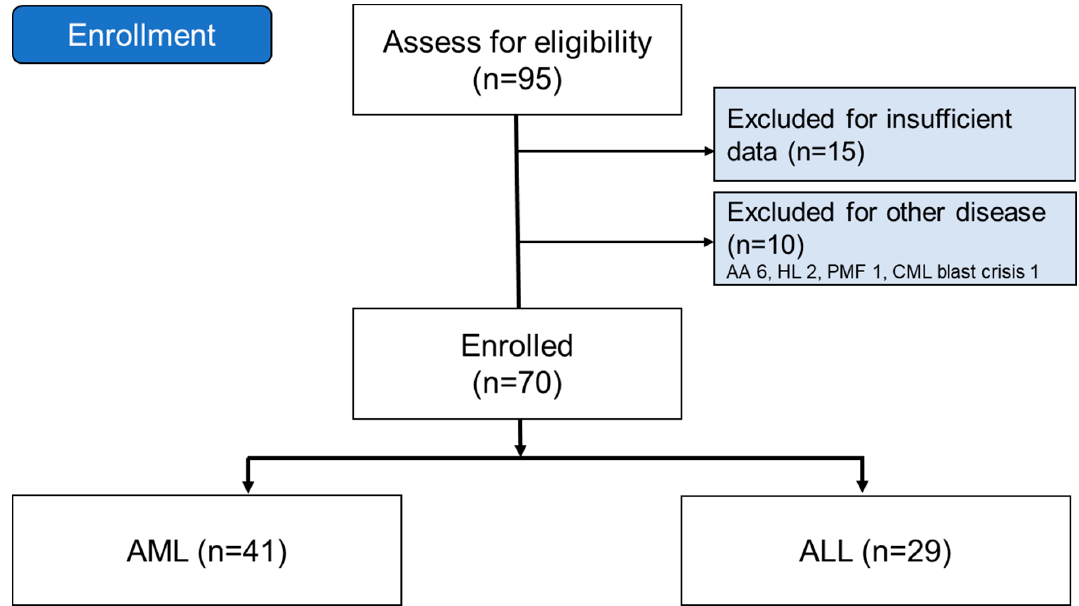
Figure 1. CONSORT diagram.